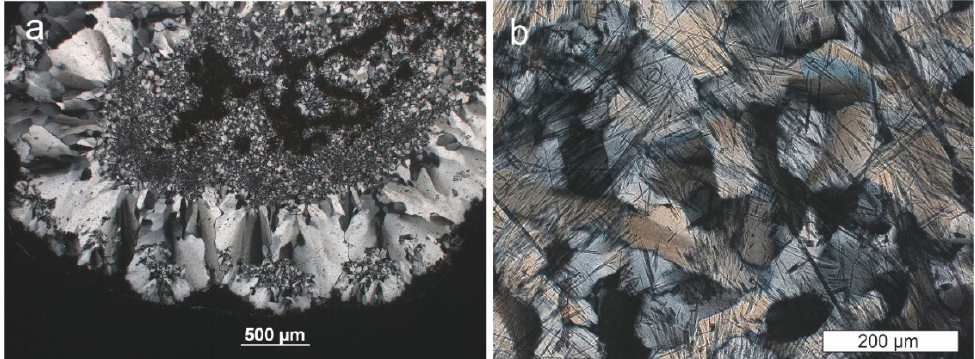
Figure 13. Transmitted light (crossed polars) micrographs showing typical appearance of SiO 2 phases. ( a ) Filament core encrusted by different silica layers showing grain coarsening from micro ‐ crystalline chalcedony (center) to macro ‐ crystalline quartz (margin). ( b ) Matrix of coarse ‐ grained quartz with needle ‐ like inclusions of mordenite.